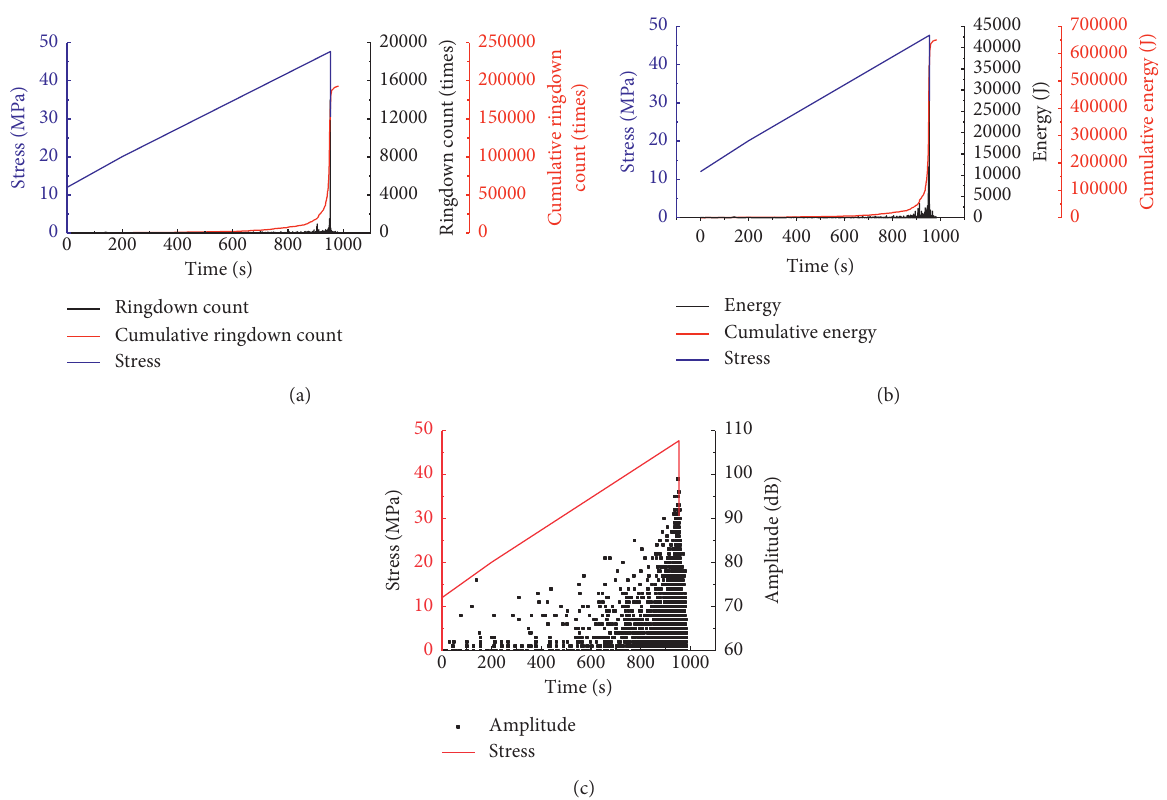
Figure 8: Acoustic emission characteristic map of the porous gas-bearing coal sample: (a) stress-ringdown count-cumulative count-time; (b) stress-energy-cumulative energy-time; (c)